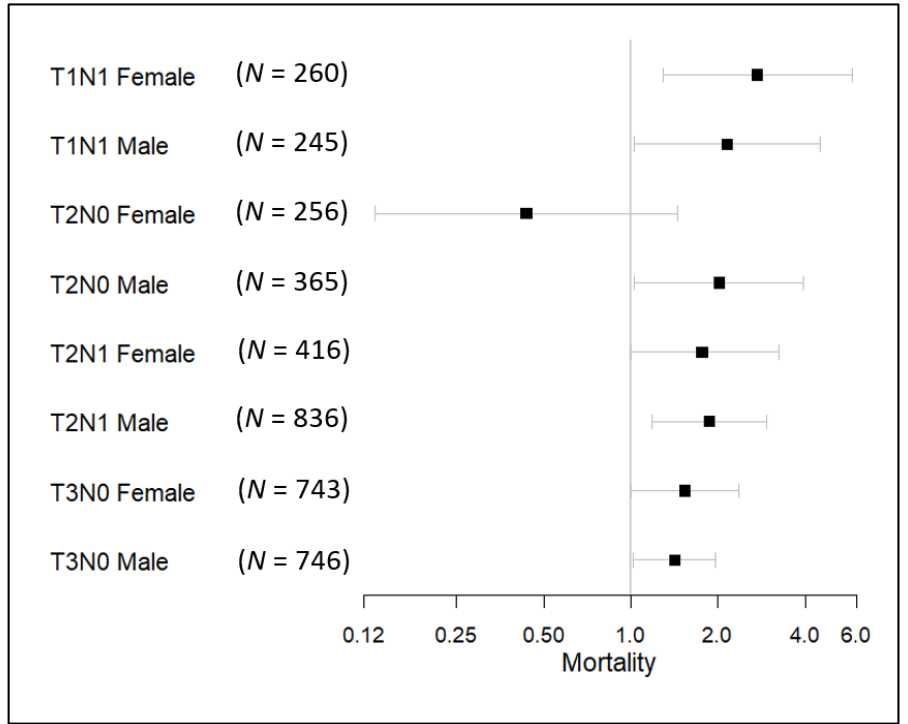
Figure 2. Subgroup analysis of the risk of NSCLC-specific death caused by using PORT. Note: the adjusted factors include year of diagnosis, age of diagnosis, race, pathologic grade, tumor size, position, histology, stage, and POCT use.